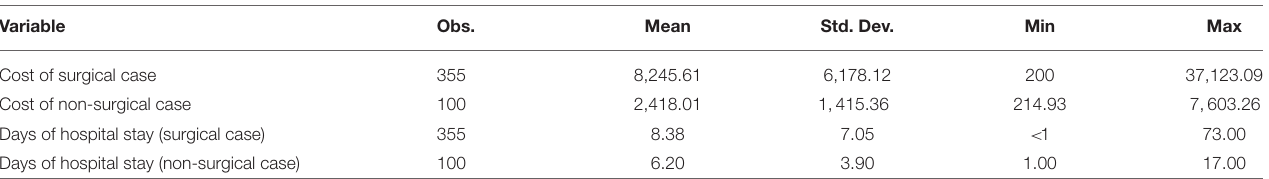
TABLE 2 | Average DRG cost and hospital stay days by neuro-surgical group.